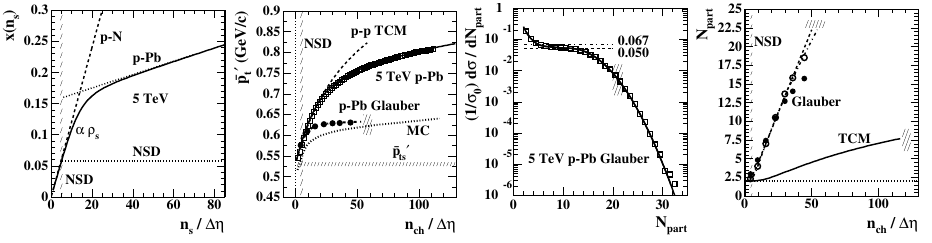
Figure 4. First: Model for TCM x ( n s ) parameter (solid curve). Second: 5 TeV p -Pb ¯ p t data (open points) compared to TCM (solid curve) and predictions from a Glauber analysis (solid points). Third: Glauber-model cross-section distribution on N part . Fourth: Comparison of Glauber (points) and TCM (solid curve) predictions for N part vs charge density ¯ ρ 0